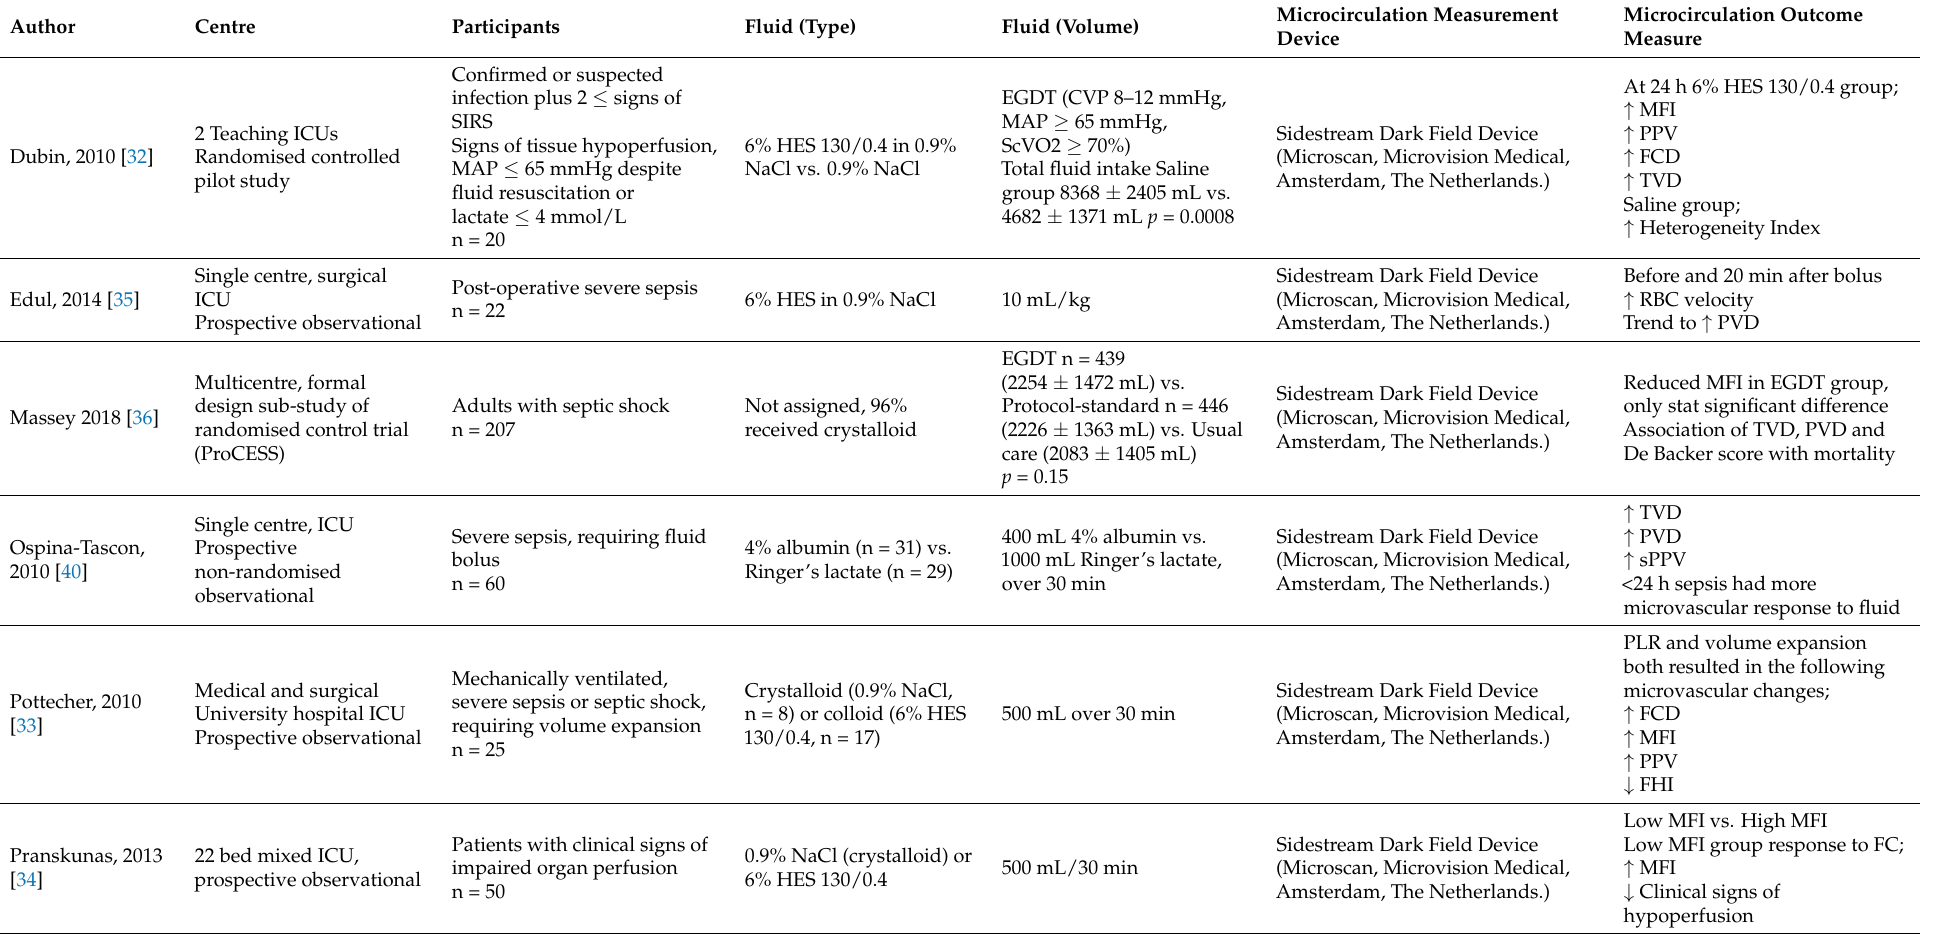
Table 1. Characteristics of included studies. TVD = Total vessel density, PVD = perfused vessel density, FCD = functional capillary density, sPPV = proportion